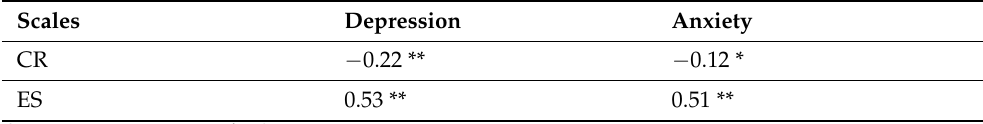
Table 3. Correlations between the Malay version of the ERQ-CA and the DASS-21 scales. Scales Depression Anxiety CR − 0.22 ** − 0.12 * ES 0.53 **